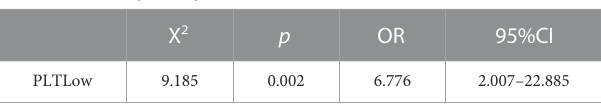
TABLE 3 The analysis of platelet and death